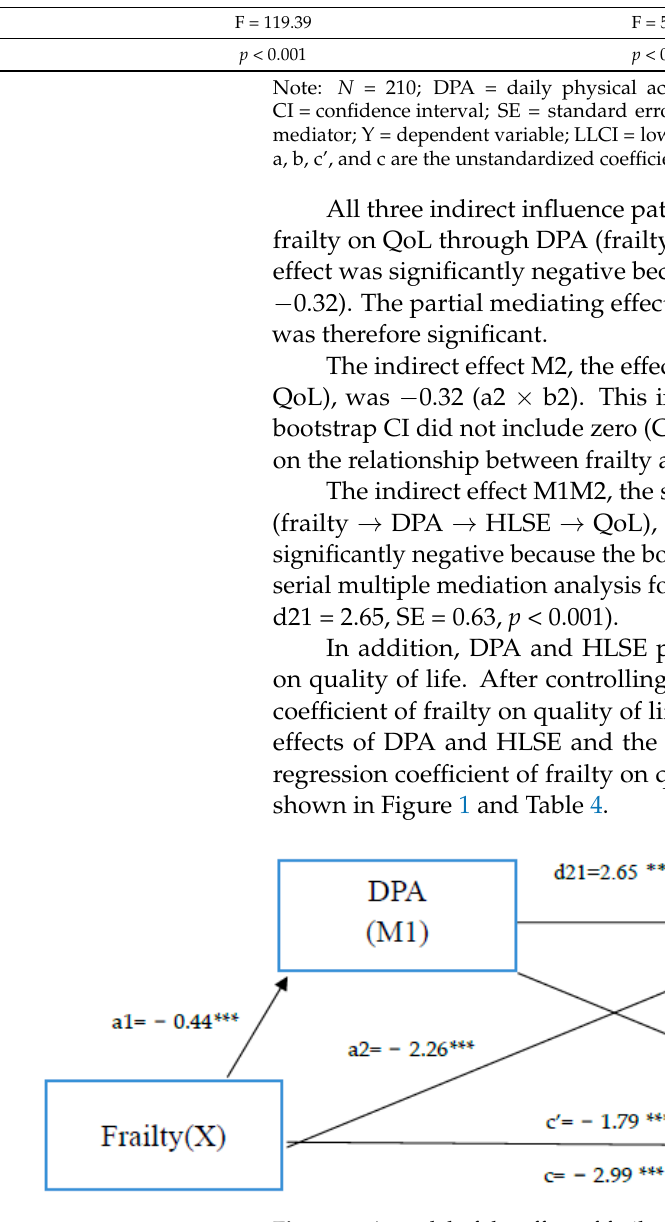
Figure 1. A model of the effect of frailty (independent variable, X), through the mediators DPA (first mediator, M1) and HLSE (second mediator, M2) in series, on QoL (dependent variable, Y). DPA = daily physical activity; HSLE = healthy life self-efficacy; QoL = quality of life; B = unstandardized regression coefficients. *** p <